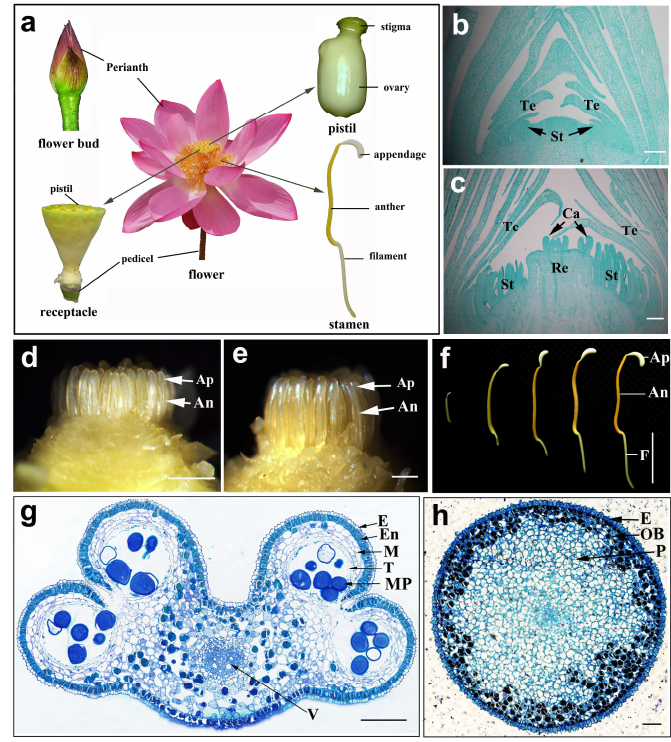
Figure 1. Development and transverse sections of the anther and appendage of N. nucifera ‘Honghu Hong’. ( a ) Scheme of the flower morphology and its generative structures of ‘Honghu Hong’. ( b ) Longitudinal section at the stamen primordium differentiation stage, the arrows indicate the stamen primordium. ( c ) Longitudinal section at the pistil primordium differentiation stage, the arrows indicate the carpel. ( d – f ) Anther and anther appendagesat different developmental stages, the arrows indicate the anthers and the appendages respectivly. ( g ) Transverse section of the anther at the mature pollen stage. ( h ) Transverse section of the anther appendage at the young microspore stage. An, anther; Ap, appendage; Ca, carpel; E, epidermis; En, endothecium; F, filament; M, middle layer; MP, mature pollen; OB, osmiophilic body; P, parenchyma; Re, receptacle; St, stamen; T, tapetum; Te, Tepal; V, vascular elements. ( b , c ) Bar = 100 μm; ( d , e ) Bar = 0.3 mm; ( f ) Bar = 10 mm; ( g , h ) Bar = 10 μm.